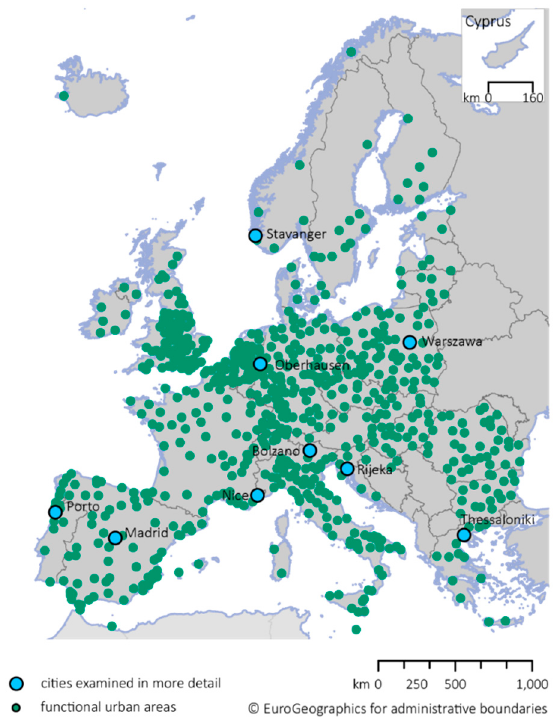
Figure 1. Location of selected FUAs.